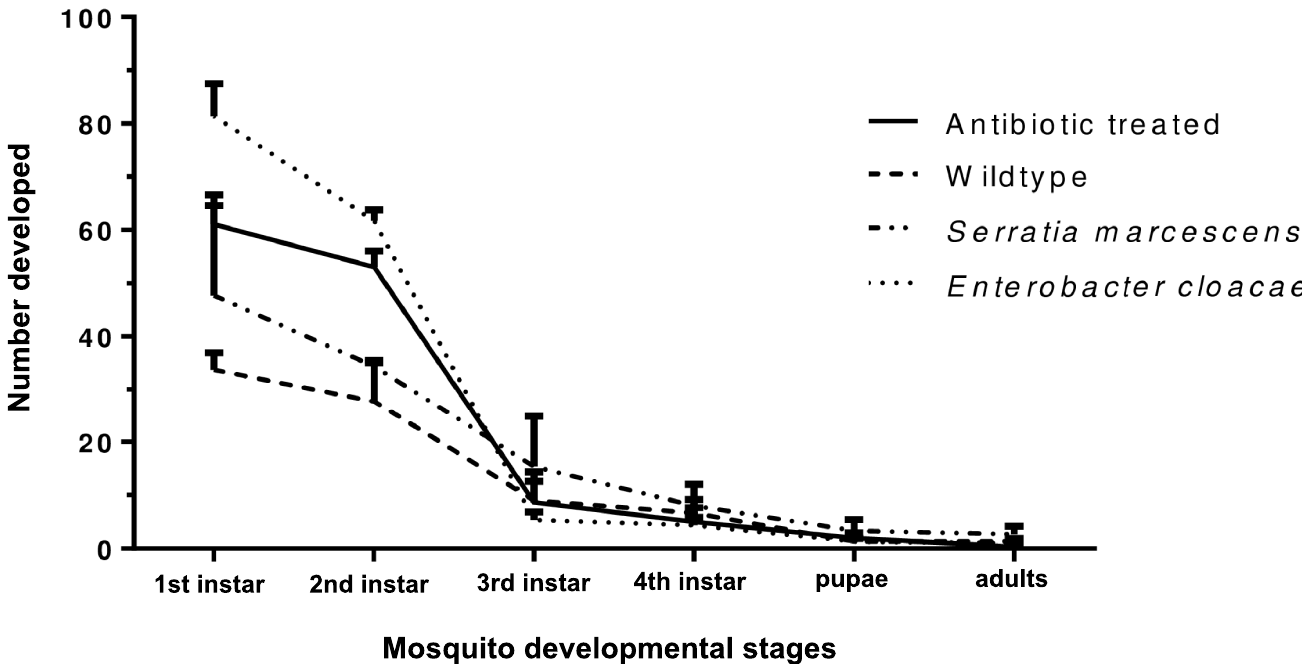
Fig 4. Developmental successes of An . gambiae from eggs to adults following bacteria reintroduction. Percentages were calculated based on the number of eggs laid.